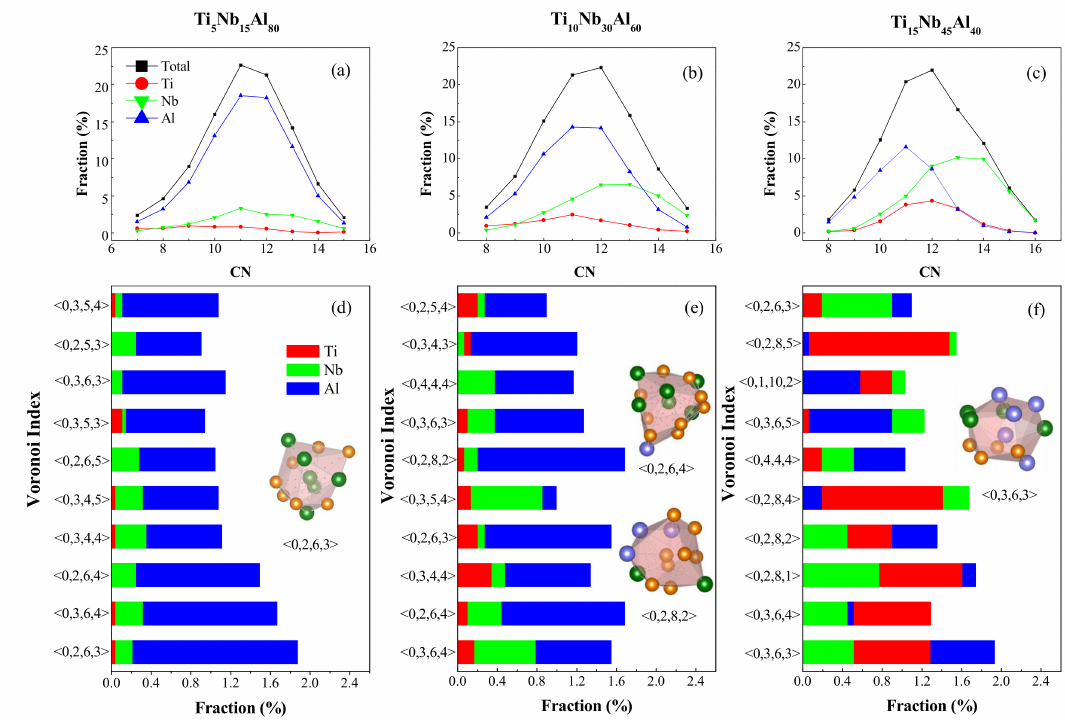
Figure 6. The distribution of Voronoi polyhedrons around Ti, Nb, and Al atoms in Ti 15 Nb 45 Al 40 glassy alloy. ( a – c ) The distributions of total and partial CN in (TiNb 3 ) 1 − x Al x (x = 80, 60, 40 at.%) metallic glasses. ( d – f ) The distributions of the dominant coordination polyhedrons centered on each unitized